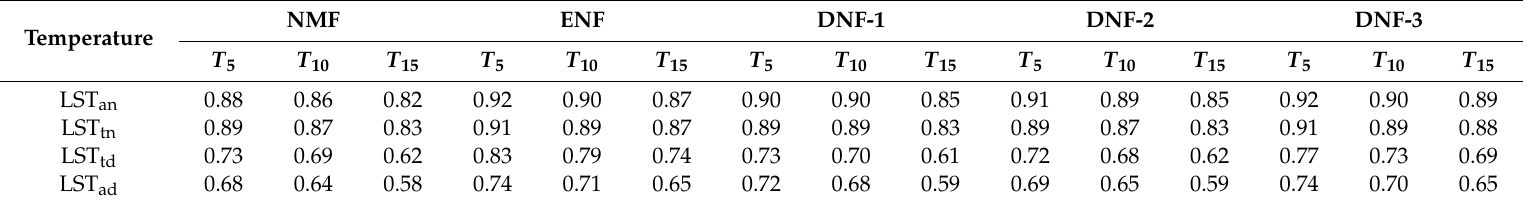
Table 4. Pearson correlation coe ffi cients (r) among four land surface temperatures (LST) and in situ measured temperatures ( T s ) at the five sites during the measurement.